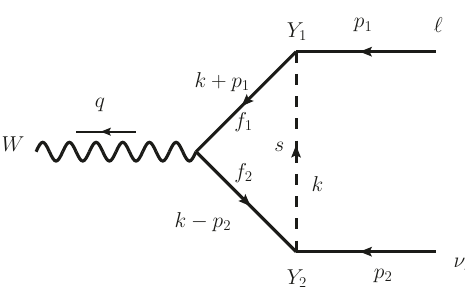
Figure 14 . Representative diagram for one-loop correction to the W → ‘ν ‘ vertex.